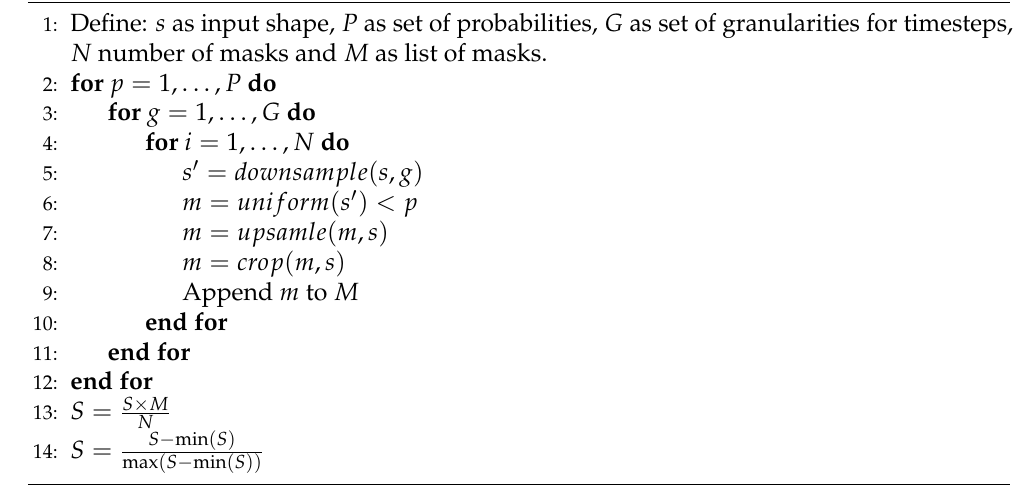
Algorithm 1 Mask